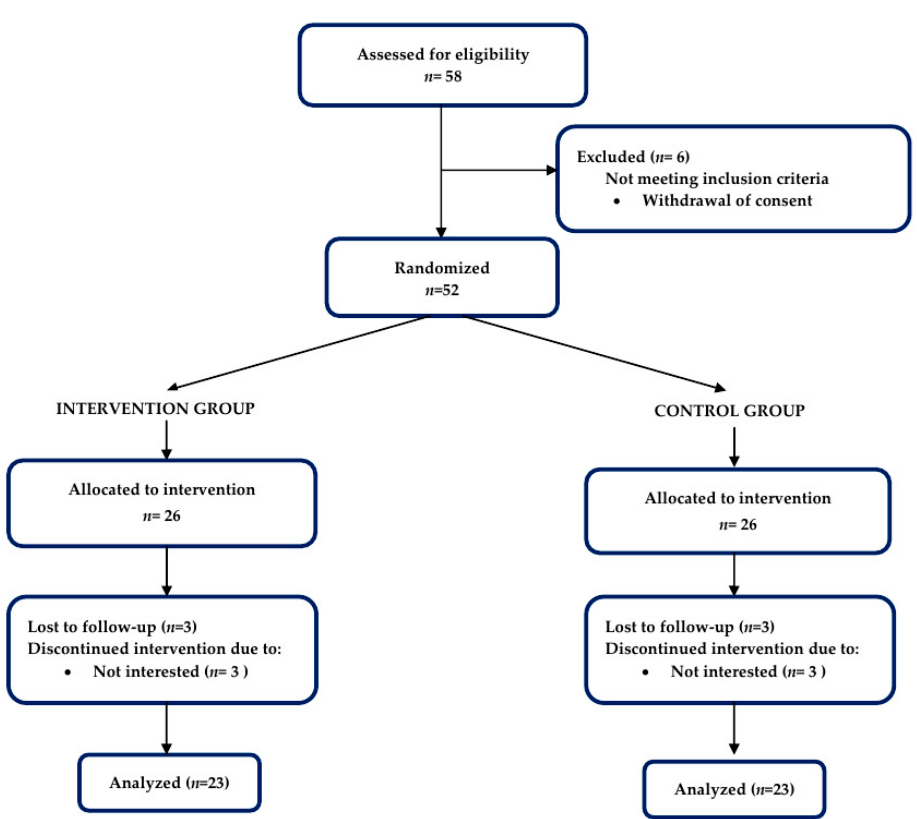
Figure 1. CONSORT flow diagram.